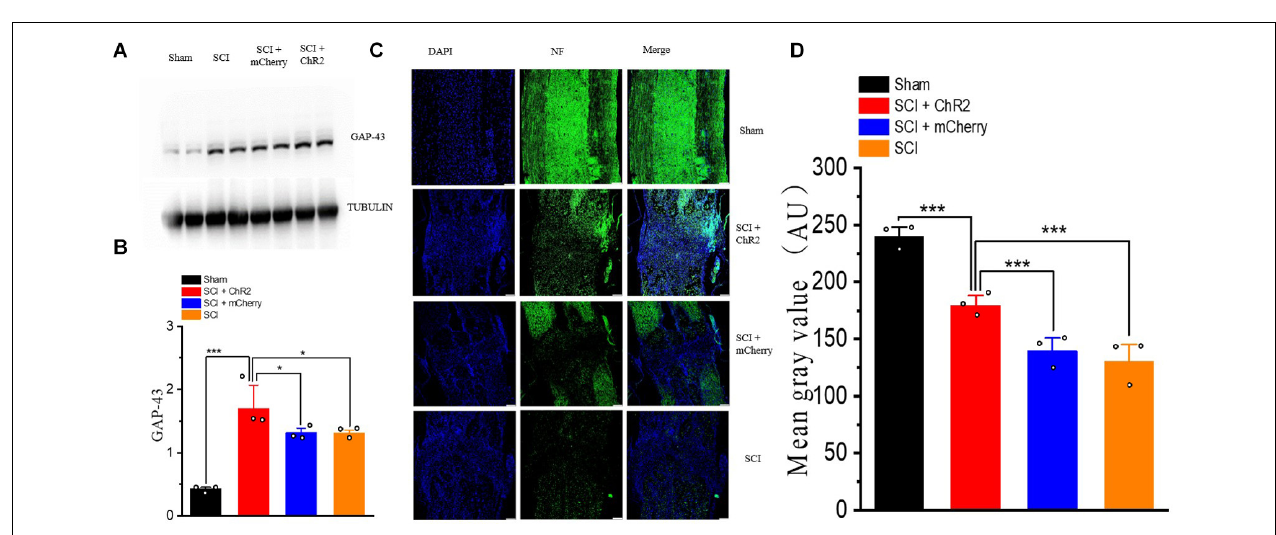
FIGURE 6 | Accurate stimulation of M1 glutamatergic neurons increased the expression of neurotrophin after SCI in rats. (A) WB bands of nerve growth-related factor BDNF and NGF proteins. (B,C) Expression of BDNF and NGF protein. [protein content = target protein gray value/internal reference gray value; * P < 0.05, *** P < 0.001, n = 3 rat/group, using one-way ANOVA. Data are shown as means (bar graphs) and standard error of the mean (error bars), with individual data points indicated as circles].